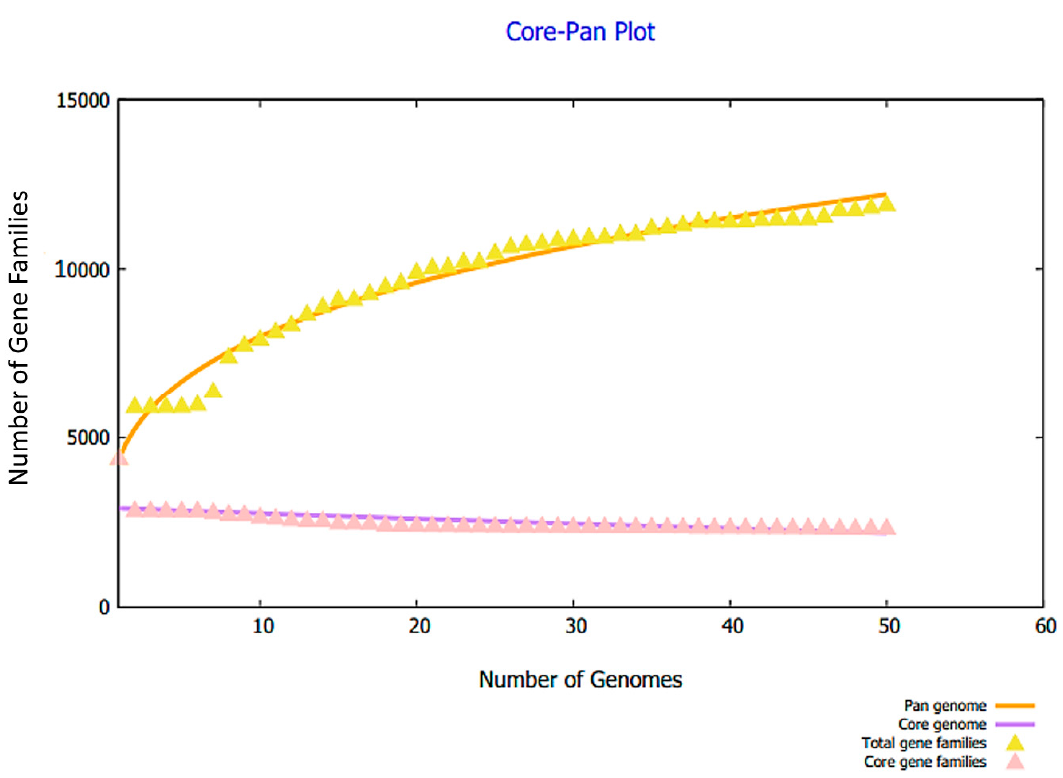
Figure 3. Pan-core plot of 50 strains of E. hormaechei.